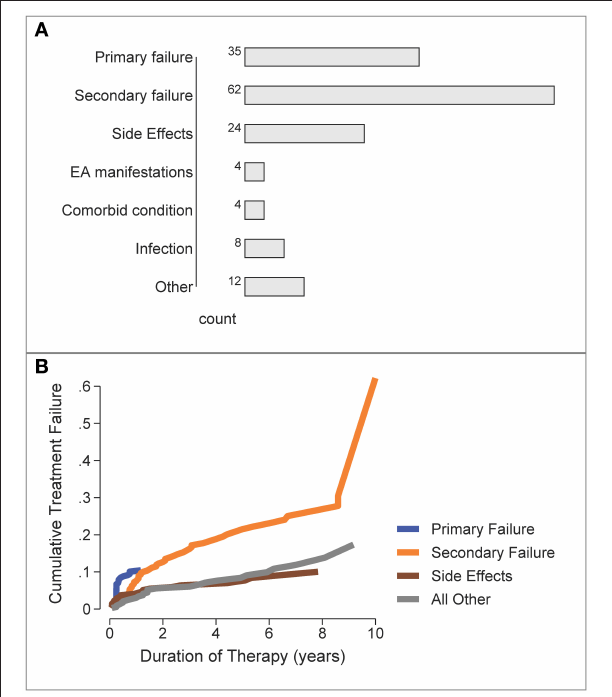
FIGURE 4 | Reasons for b/tsDMARD failure over all patients and all treatment failures. (A) Frequency of specific failure types. EA, extra-articular/extra- musculoskeletal. (B) Cumulative Incidence of b/tsDMARD failure types over time (competing risks